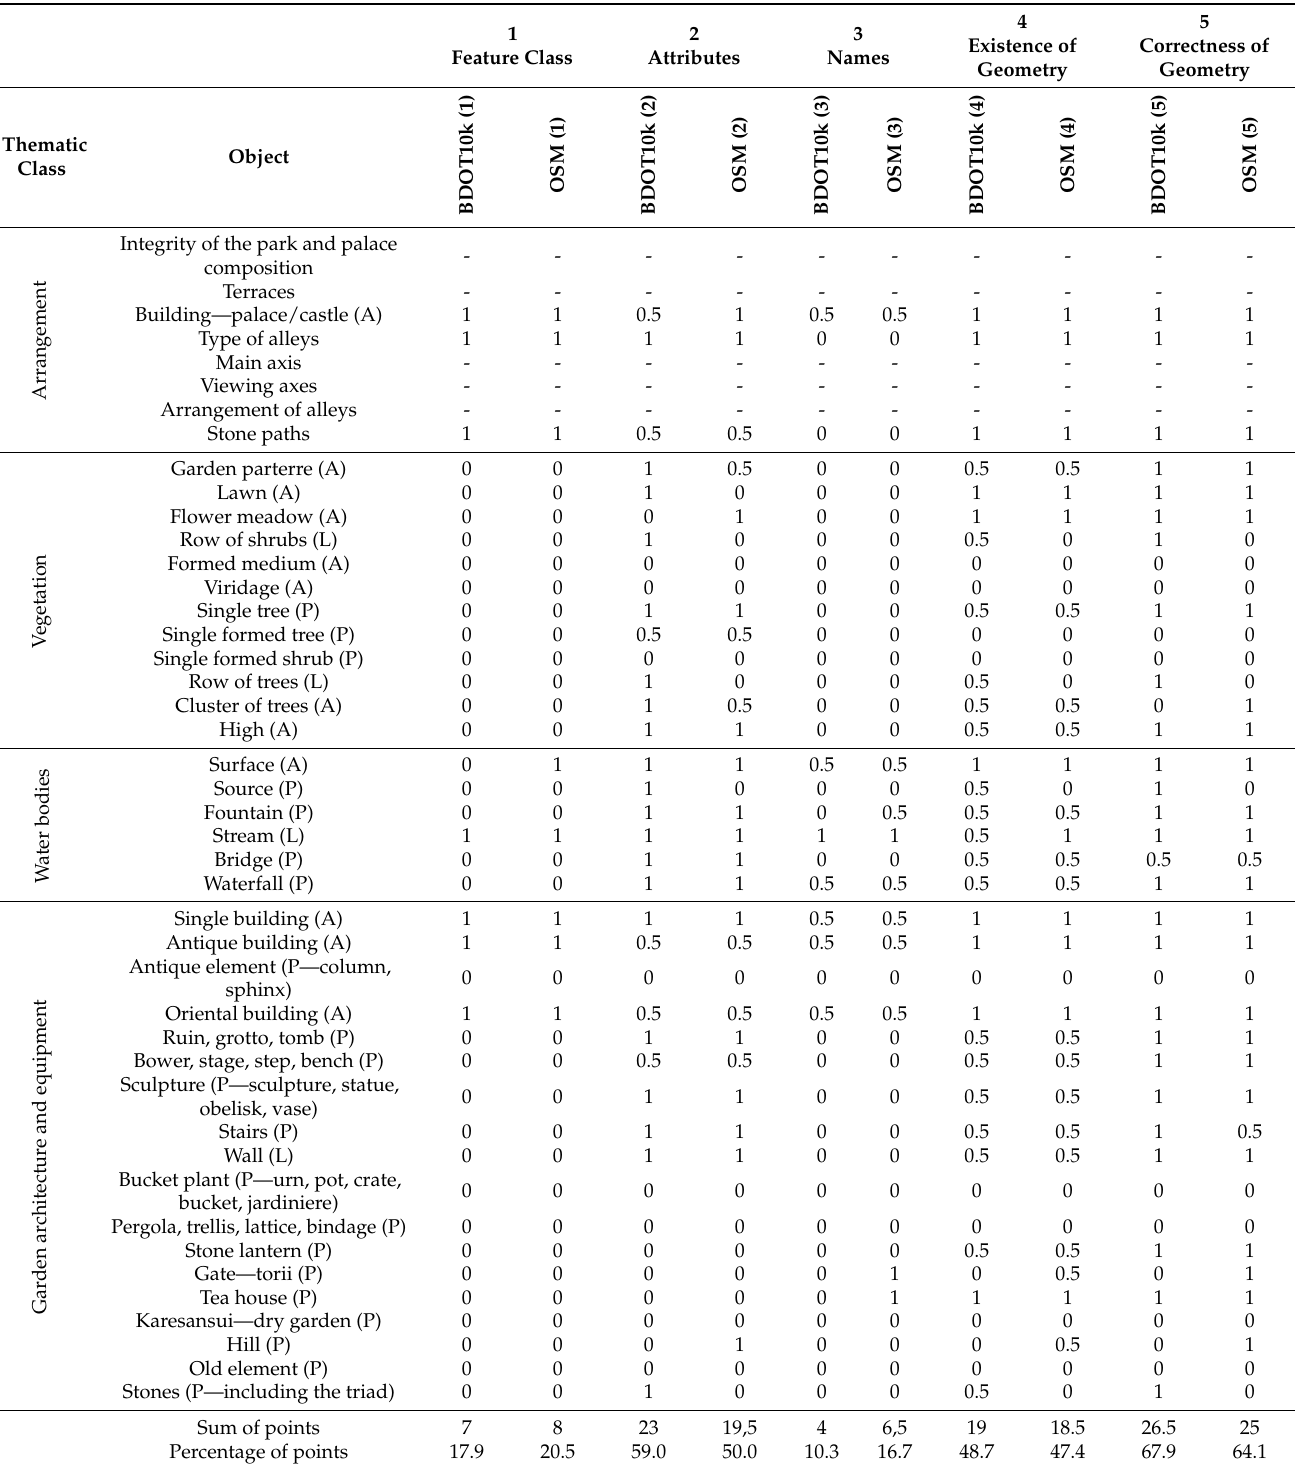
Table 2. OSM and BDOT10k assessment ratings—the second level of map detail. P, L, A—type of geometry (point, line,